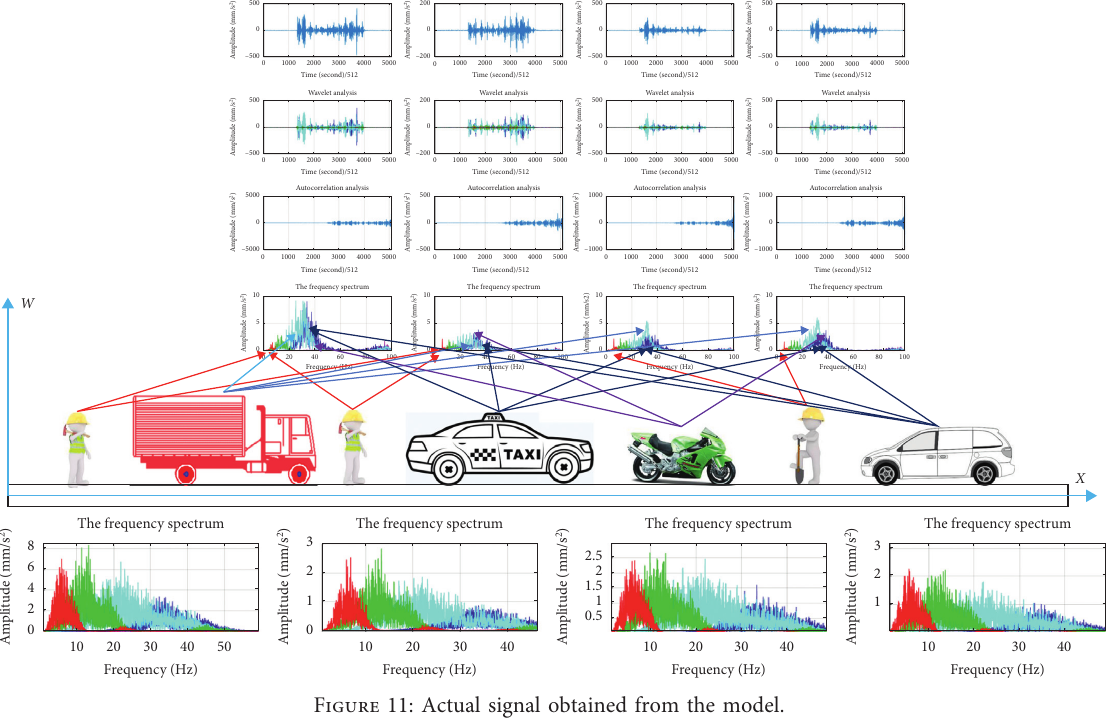
Figure 11: Actual signal obtained from the model.